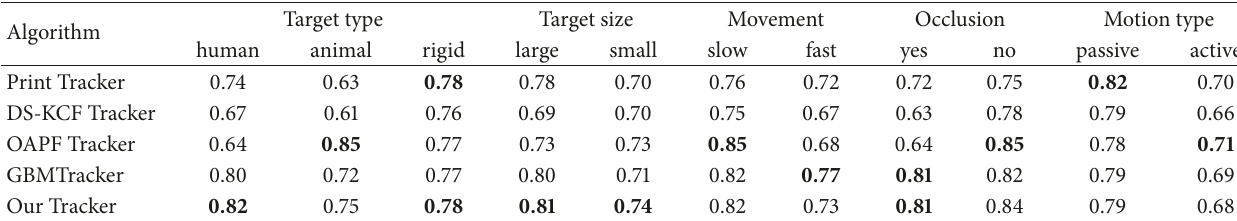
Figure 3: The pipeline of the proposed tracking approach. Table 1: SR results on the PTB dataset.